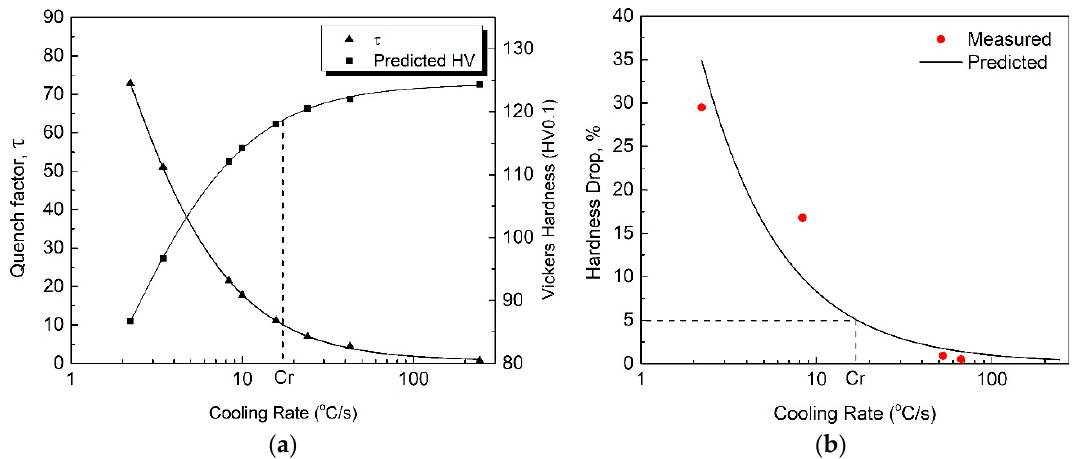
Figure 7. Effect of cooling rate on quench factor and predicted hardness ( a ) and a comparison between the measured data and predicted hardness decrease ( b ) of PM casting samples.